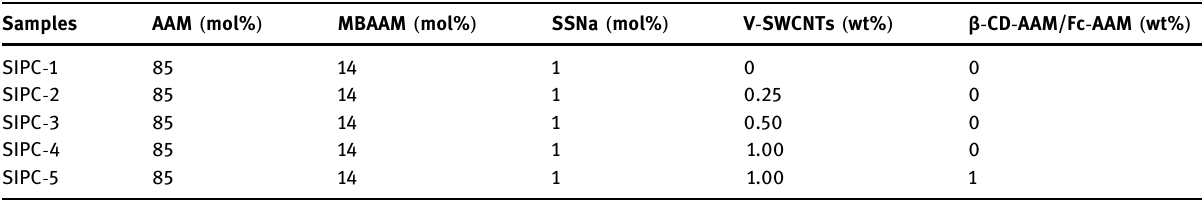
Table 1: Compositions of the prepared SIPC hydrogels